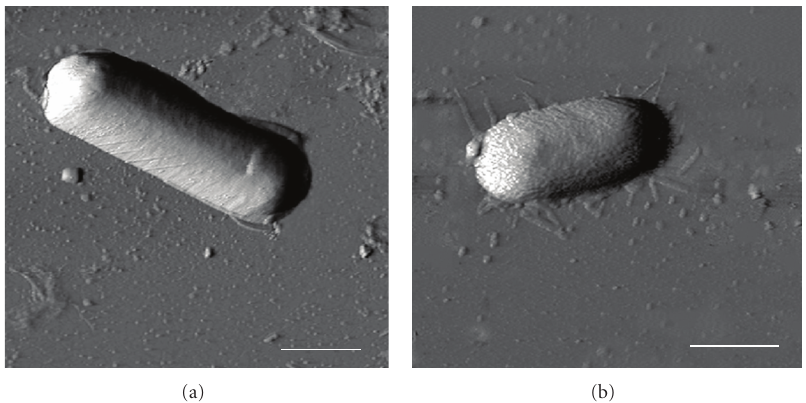
Figure 1: AFM phase images of B. cereus (a) and E. coli (b) on mica surface at 93% RH. The white bar indicates 1 μ m. There are no qualitative changes that can be seen in the pictures at di ff erent RH